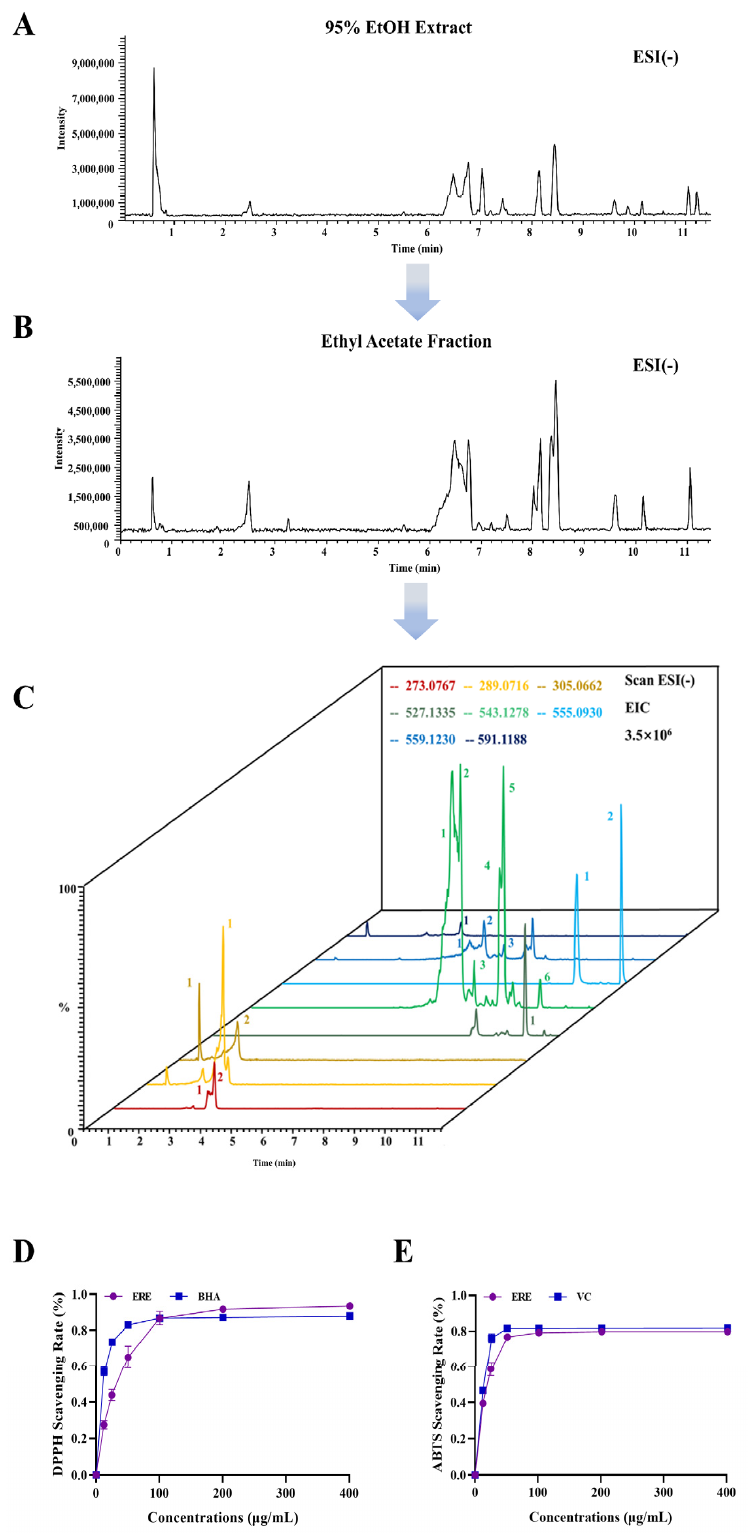
Figure 3. The total ion chromatogram (TIC) of 95% ethanol extract ( A ) and the ethyl acetate frac- tion ( B ) and the extract ion chromatogram (EIC) of the ethyl acetate fraction ( C ) in the negative mode. The DPPH ( D ) and ABTS ( E ) scavenging rate of the ethyl acetate fraction. (BHA: butylated hydroxylanisole, positive control; VC: vitamin C, positive